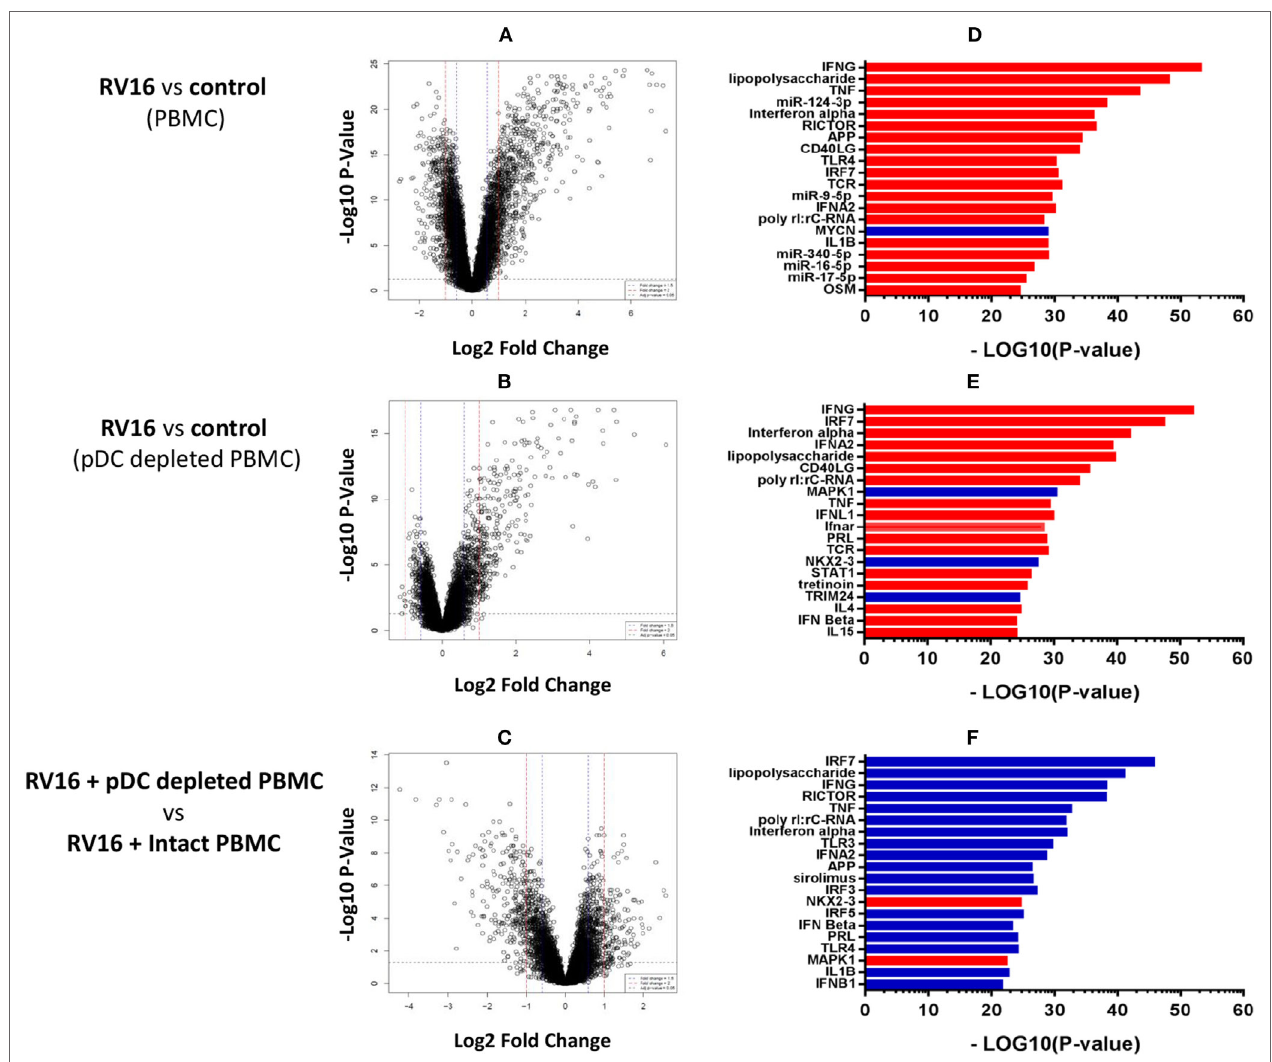
FigUre 3 | Molecular drivers of human rhinoviruses strain 16 (RV16) induced gene expression. Differentially expressed genes/molecular drivers were identified in peripheral blood mononuclear cell (PBMC) (a,D) and plasmacytoid dendritic cell (pDC)-depleted PBMC (B,e) in the presence of RV16. Comparison of RV16- stimulated pDC-depleted PBMC and intact PBMC (c,F) . Data analysis was performed by limma (a–c) and upstream regulator analysis (D–F) . The dashed horizontal line in (a–c) indicates FDR < 0.05. Drivers in red are predicted to be activated and those in blue are